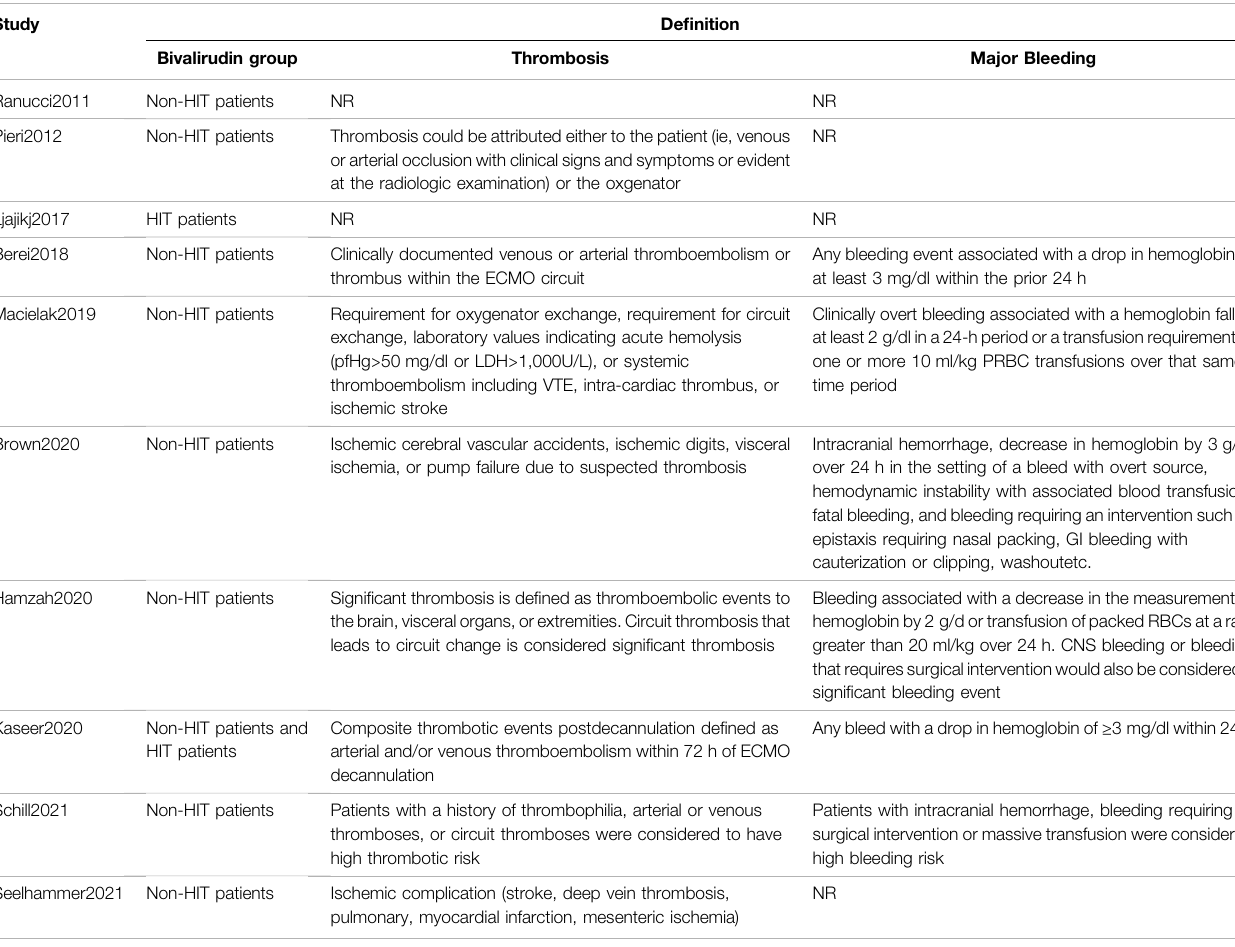
TABLE 3 | De fi nition of the bivalirudin group and clinical